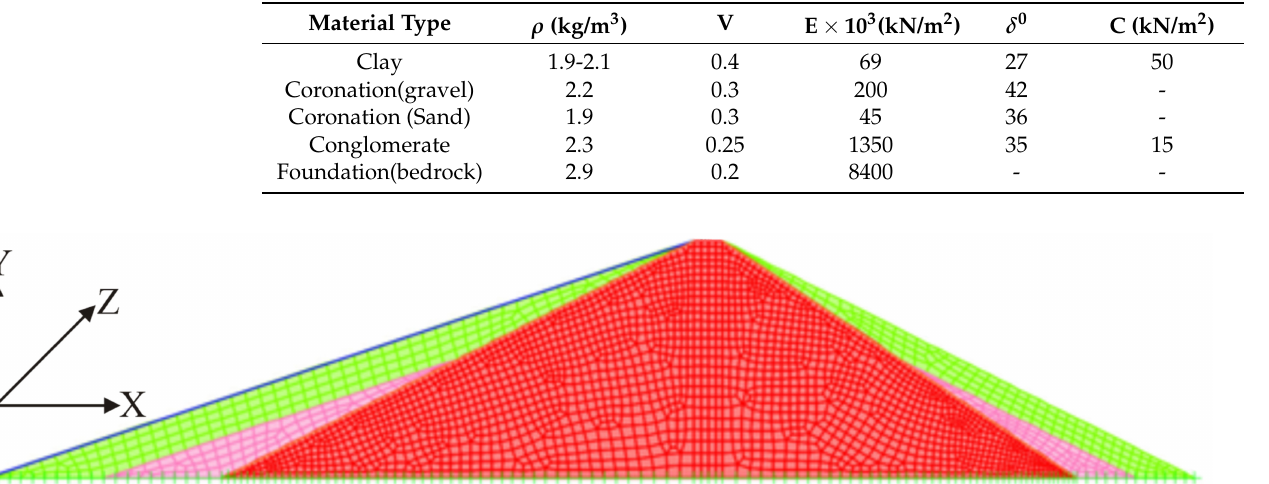
Figure 2. Geometry of the cross-section of the Sanalona Dam. Table 1. Mechanical and physical properties of the Sanalona dam materials. ρ is the density, V is the Poisson ratio, E is the elastic modulus, δ 0 is the angle of friction, and C is the cohesion.